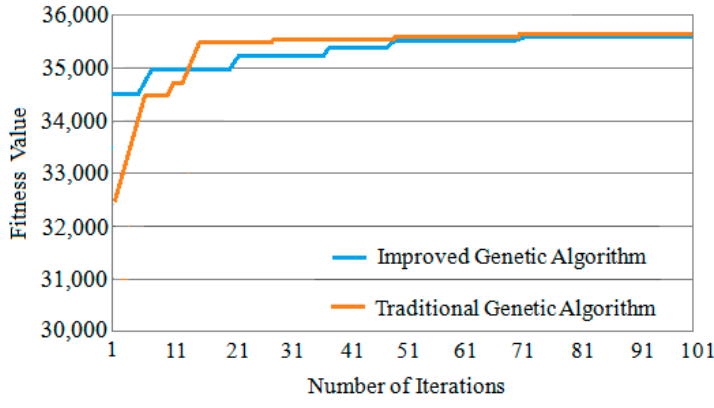
Figure 11. Convergence speed comparison of VOPD.